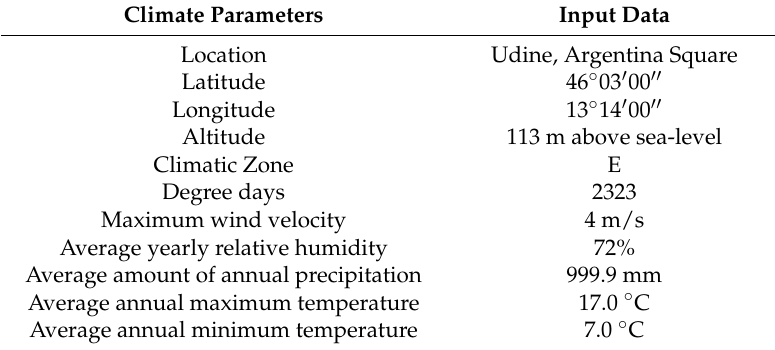
Table 5. Input data regarding the environment surrounding the Dacia Arena.